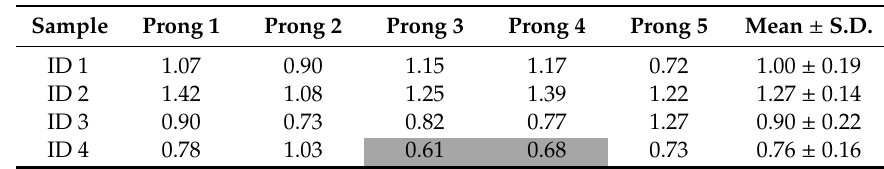
Table 2. Spring constants of prongs in printed electrodes (N / mm). Only two prongs (prongs 3 and 4 of ID 4) were out of the desired range (gray cells).